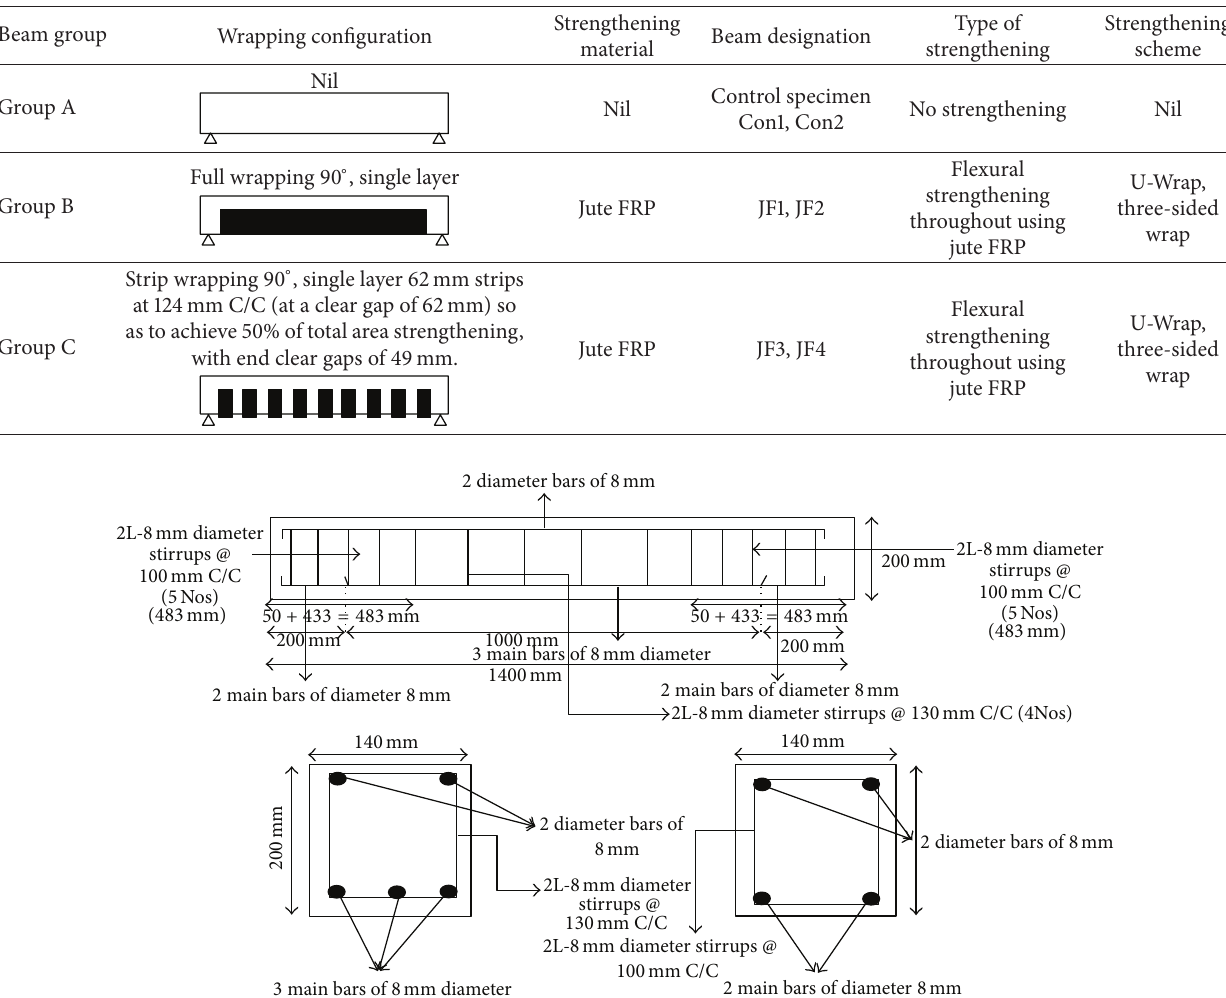
Table 2: Summary of test beams.